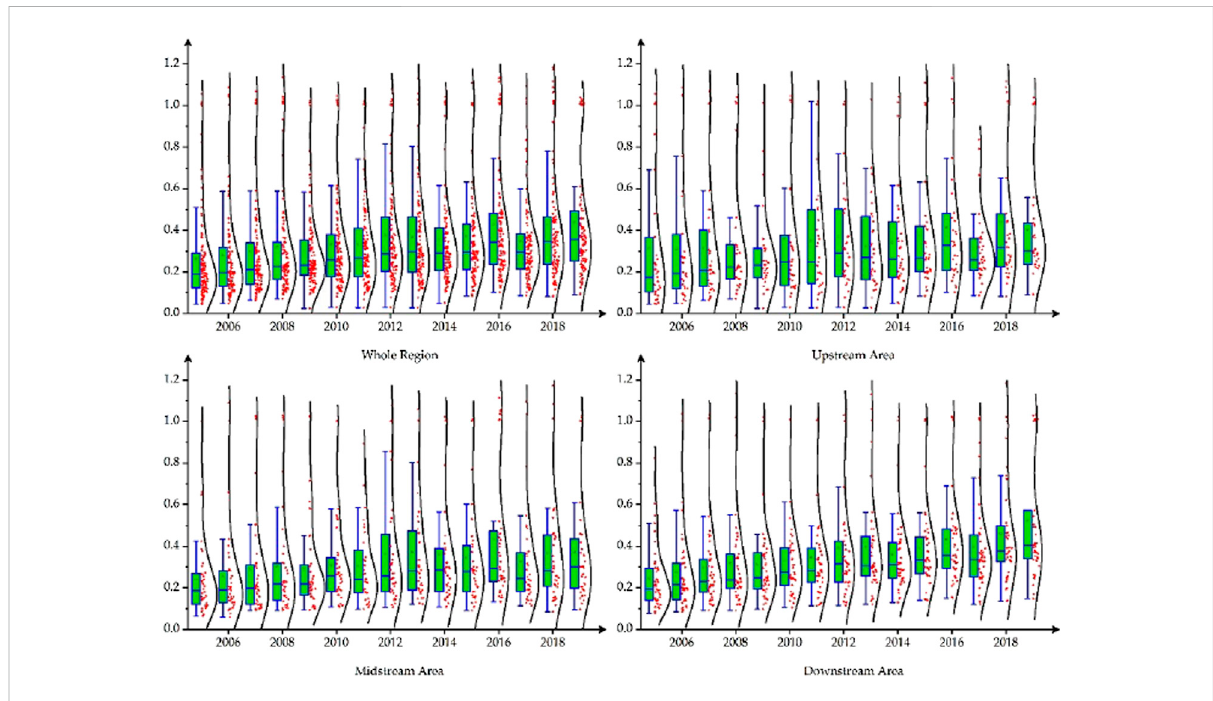
FIGURE 5 Distribution dynamics of ULGUE in the Yangtze River Economic